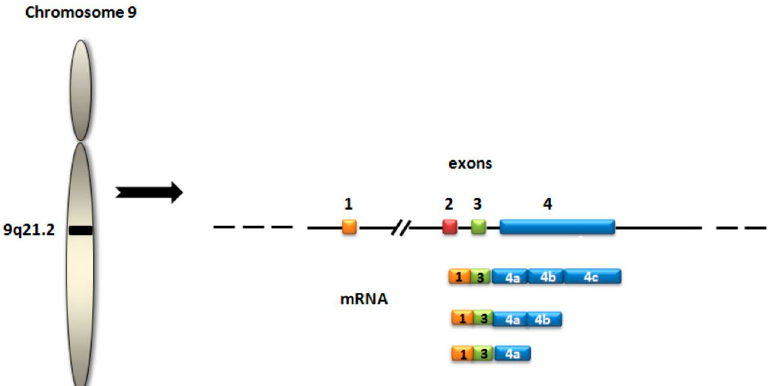
Figure 3. PCA3 gene structure. The most frequent transcript contains exons 1, 3, 4a, and 4b.